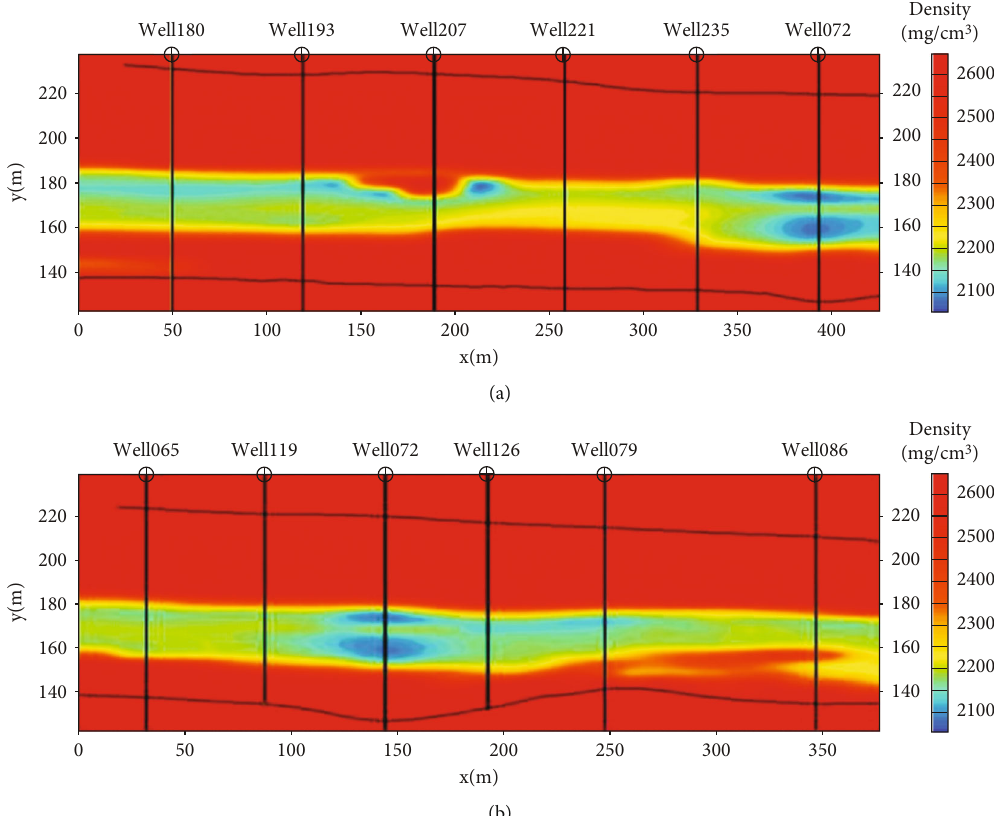
Figure 7: (a) Inversion section of density along source direction. (b) Inversion section of density perpendicular to source